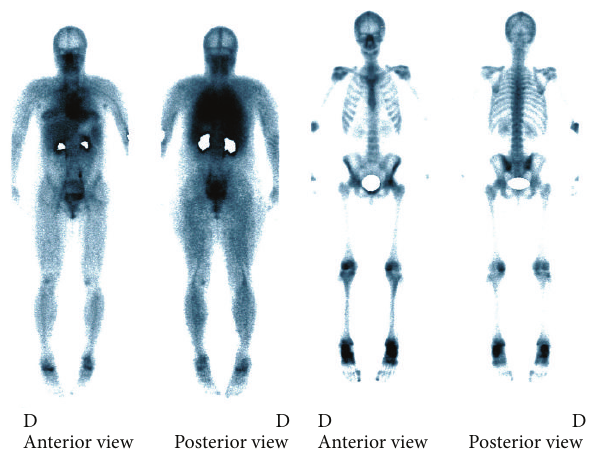
Figure 1: Bone scintigraphy performed two months after partum. Excessive uptake by both tali, bilaterally by the femoral condyles and by the left cotyle.